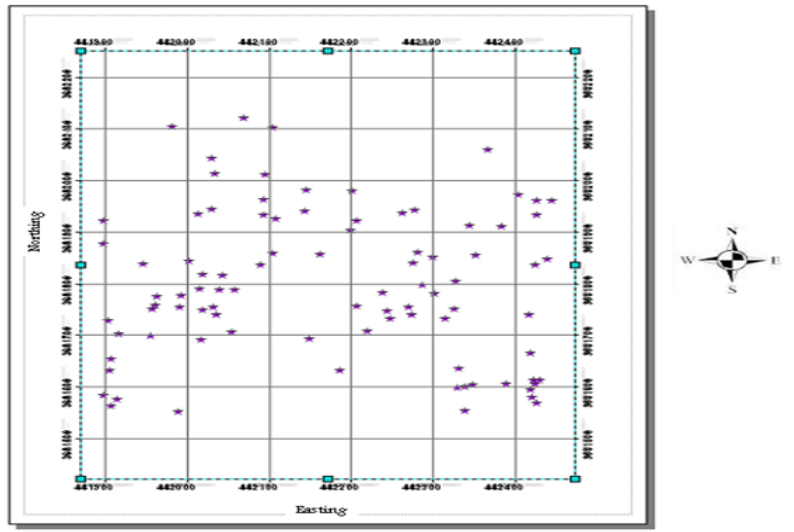
Fig. 4: Location of the adopted GCPs, as identified by the GPS